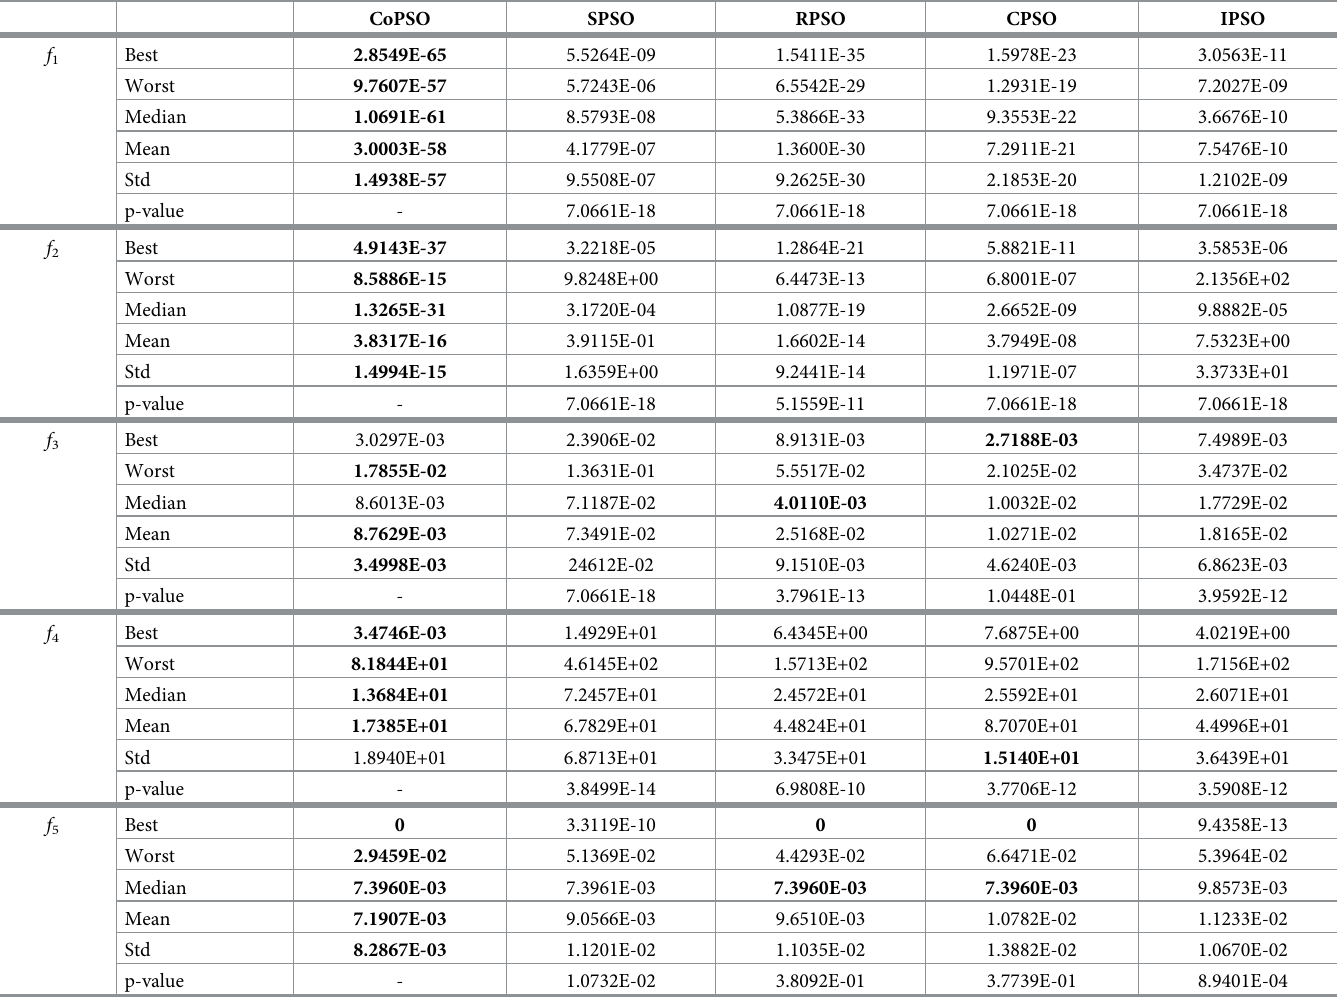
Table 2. Experimental results for all algorithms on benchmark